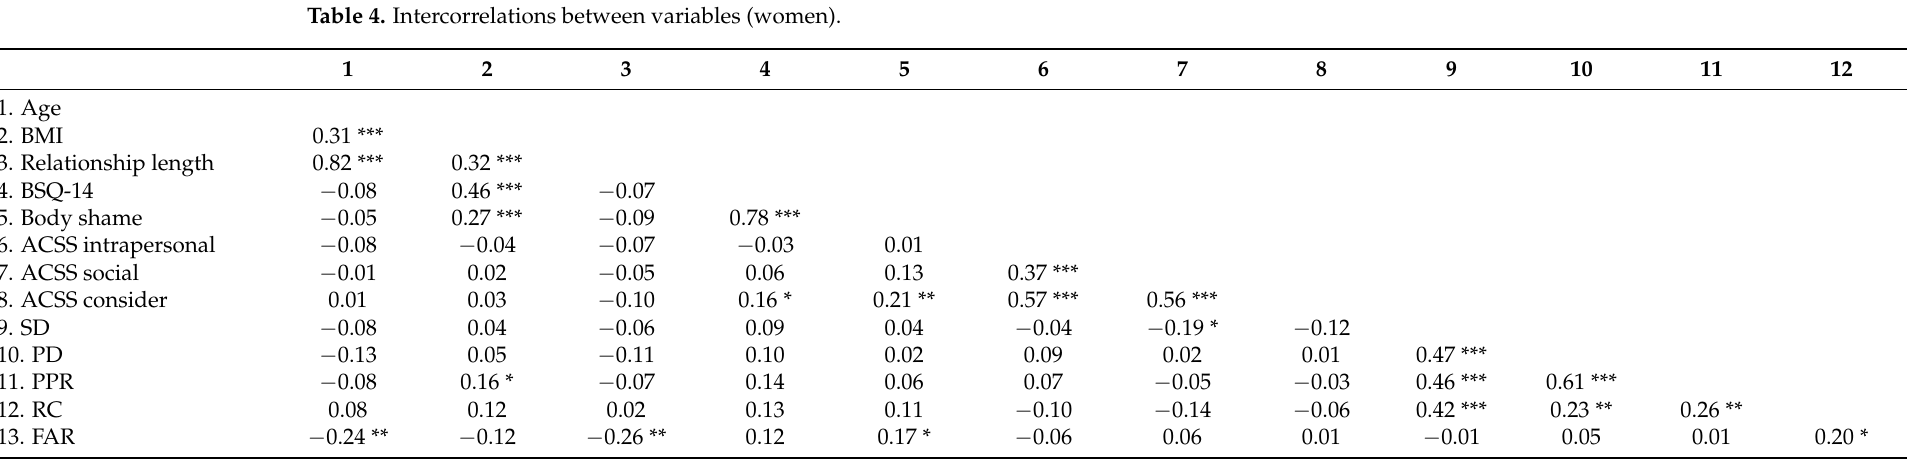
Table 4. Intercorrelations between variables